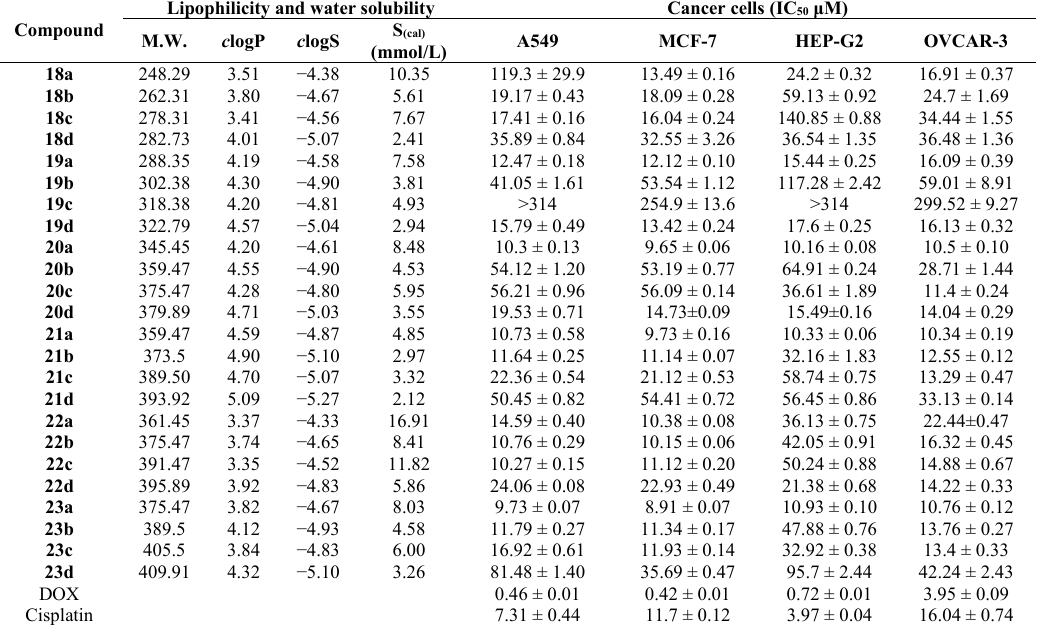
Table 1. Calculation of lipophilicity and water solubility of the benzimidazole derivatives library and the relationship between cytotoxicity against MCF-7 and OVCAR-3 cell line. (logP and logS were calculated from http://www.vcclab.org/lab/alogps/). IC 50 values given are mean ± SD of two separate experiments in